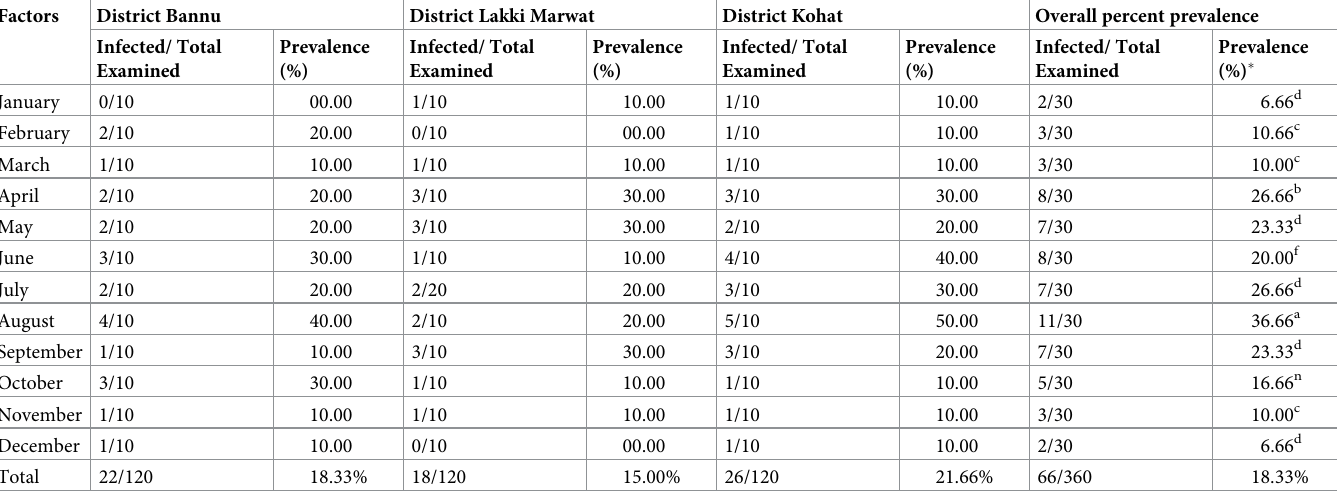
Table 3. Month wise prevalence of Cryptosporidium infection in sheep detected by simple microscopy.